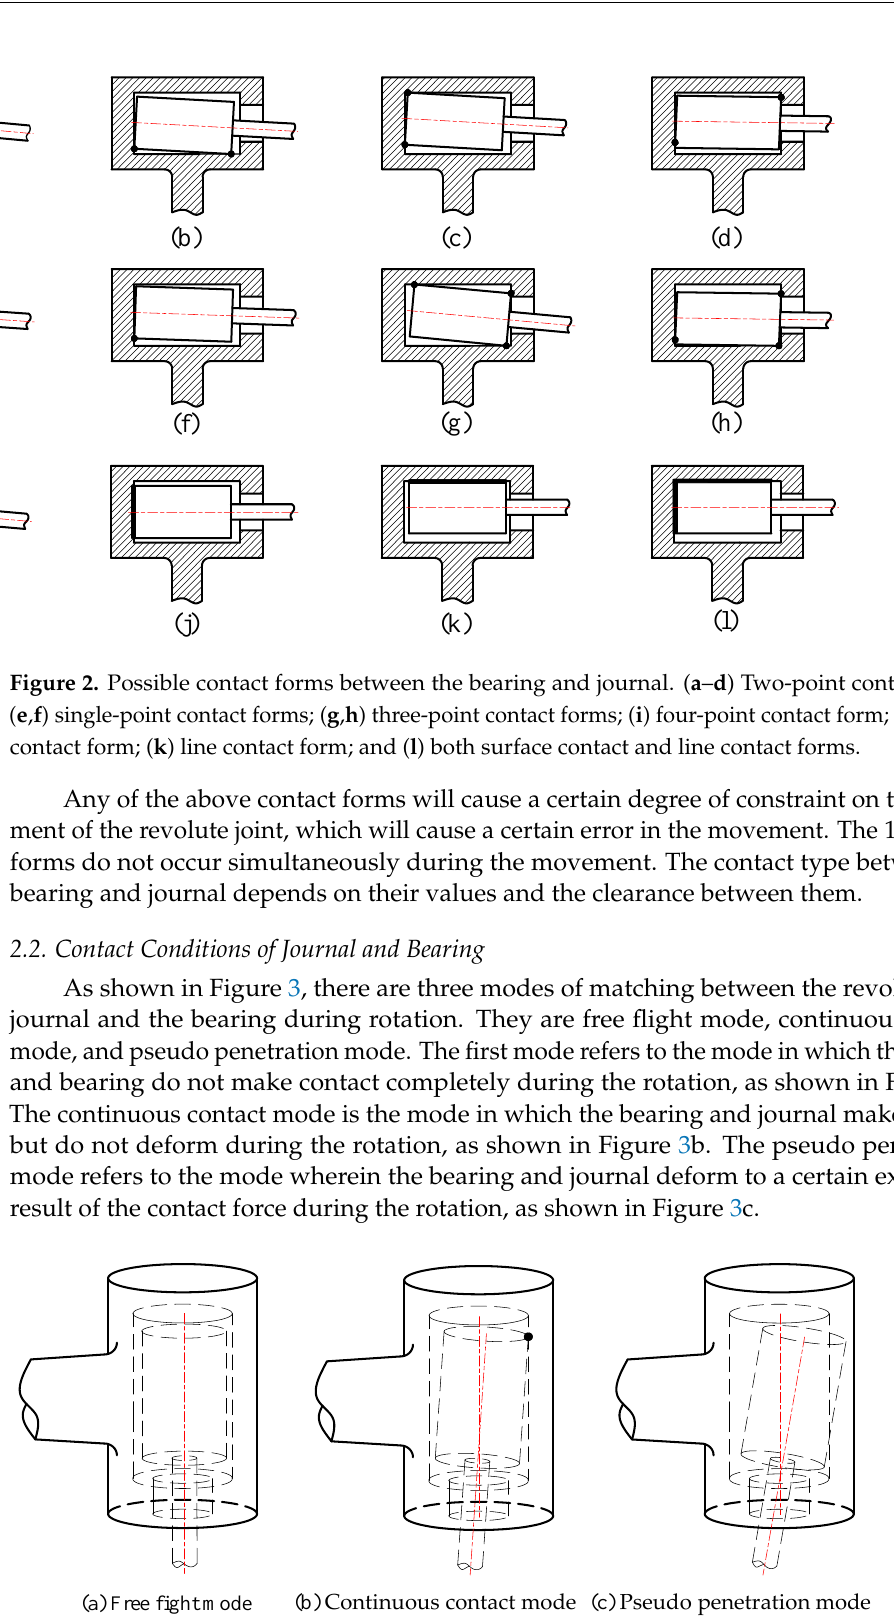
Figure 3. Contact modes.